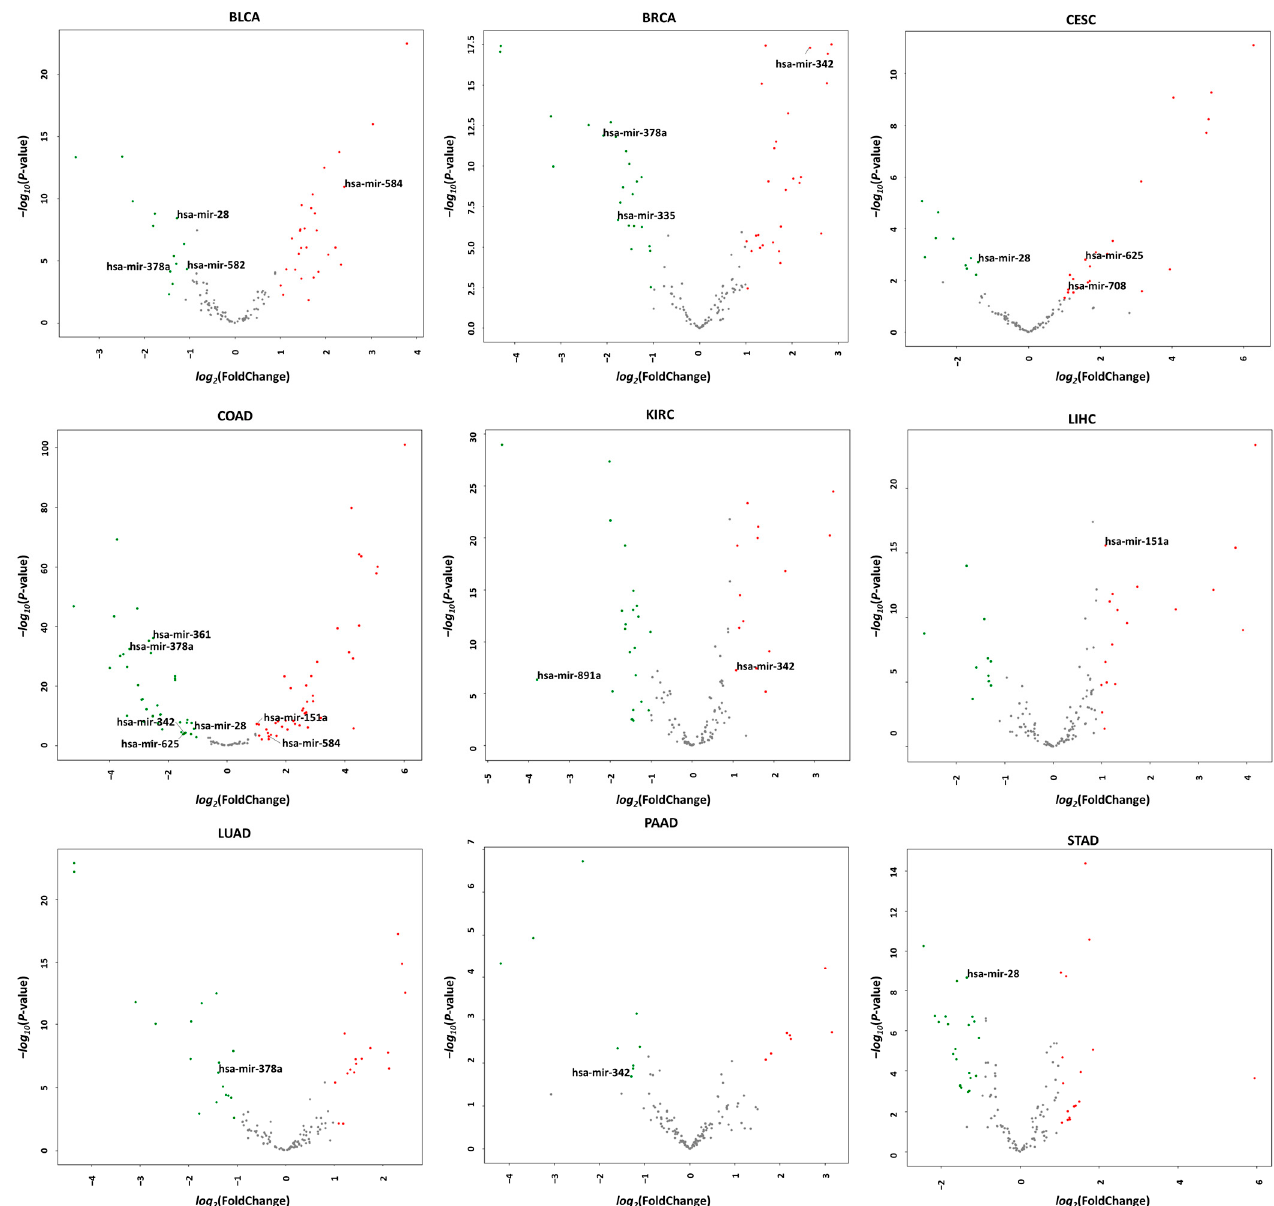
Figure 5. Volcanoplot of differentially expressed miRNAs in the tissue of 9 types of cancer obtained from TCGA database. Only those MDTEs with the significant expression alteration that satisfy the condition ( p < 0.05 and |log 2 FC| ≥ 1.0) are presented. Red dots represent significantly upregulated miRNAs, and greens for downregulated miRNAs.